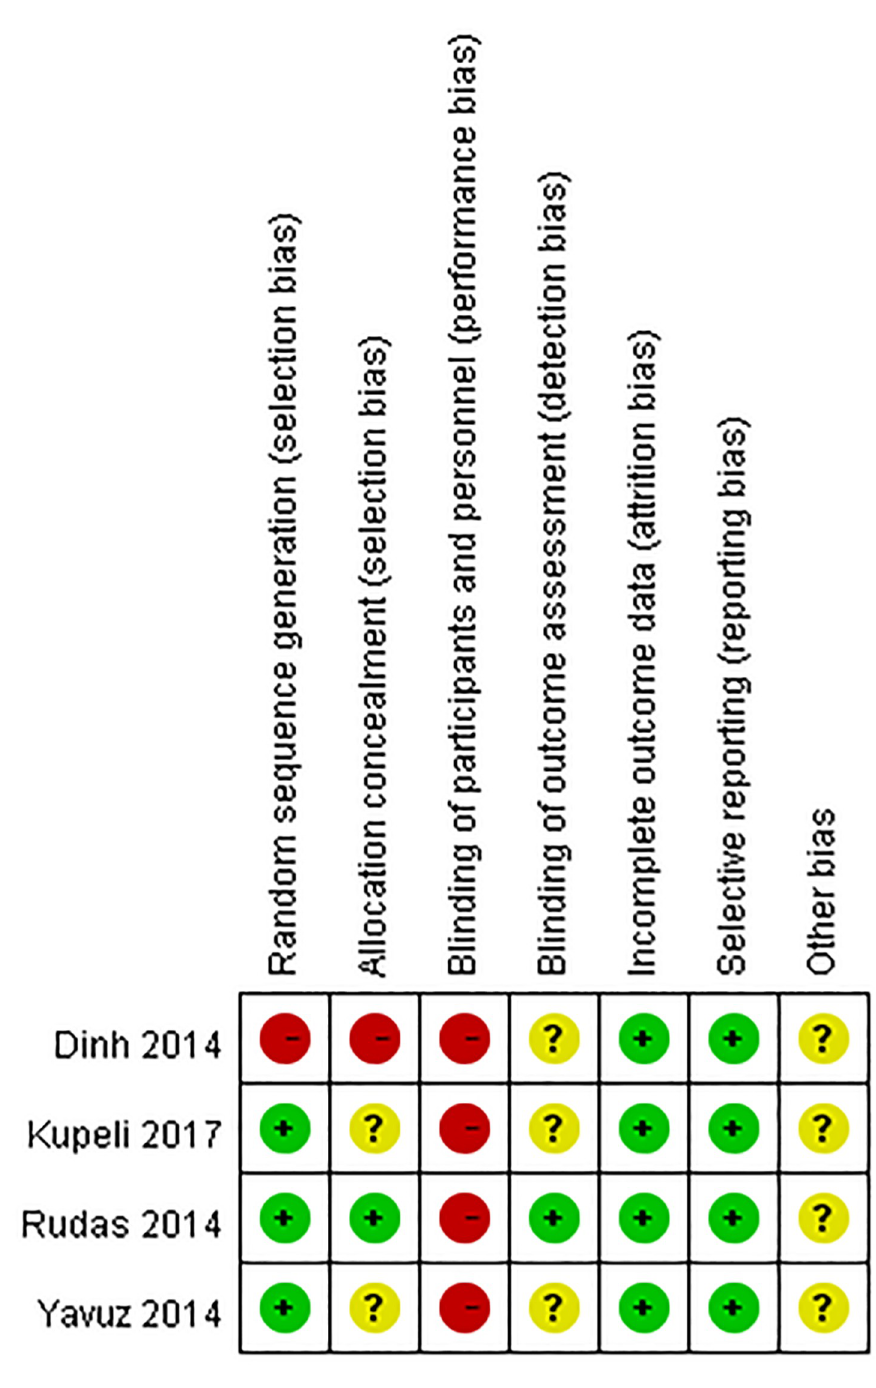
Fig 2. Risks of bias